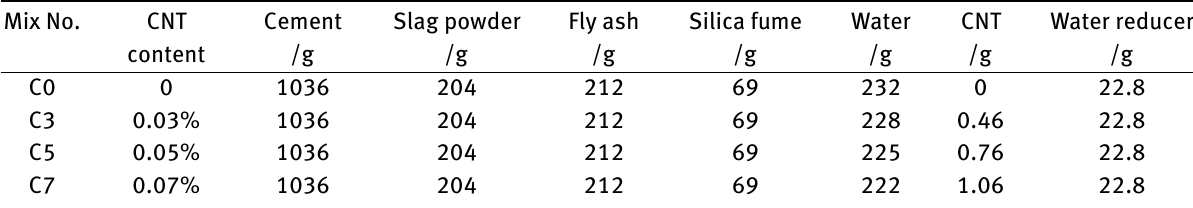
Table 4: Mixture proportion of MWCNTs reinforced UHPC Mix